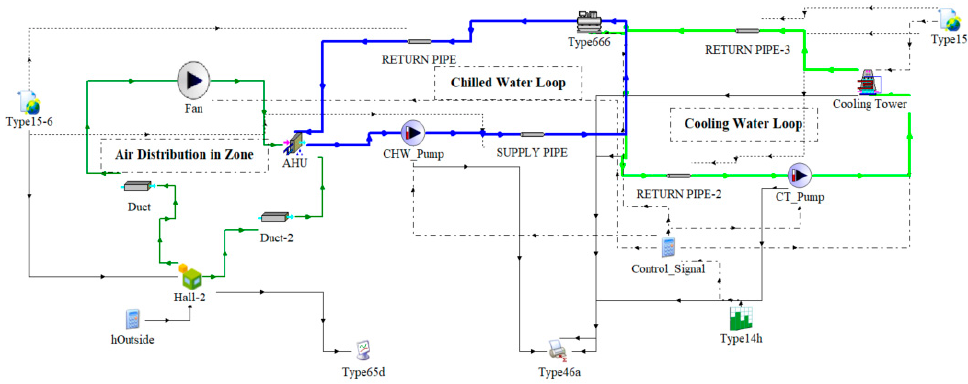
Figure 3. Solar absorption cooling system simulated in TRNSYS.